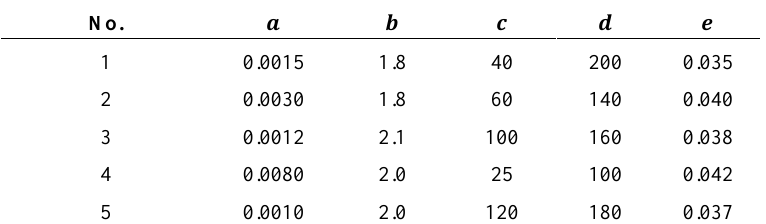
Table 7. Fuel cost coefficients.